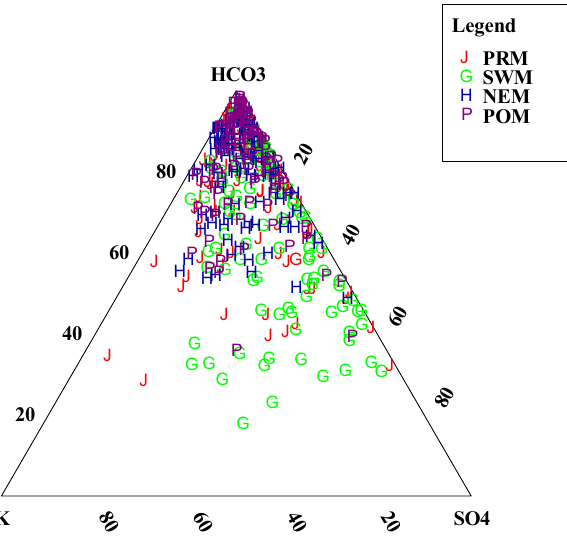
Fig. 7 Relative HCO − 3 , K + and SO 2 − 4 contents of waters of the study